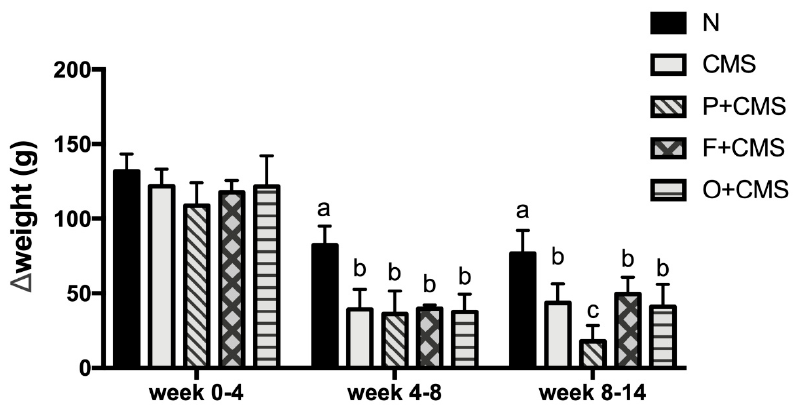
Figure 2. Weight change groups. The entire experimental period was divided into three parts. The group differences are displayed for each part. CMS was administered from week 2, and CMS significantly reduced the increase in weight during week 5–8. Data are expressed as mean ± SD (n = 8 or 9 per group). Values with different superscript letters are significantly different at p < 0.05.